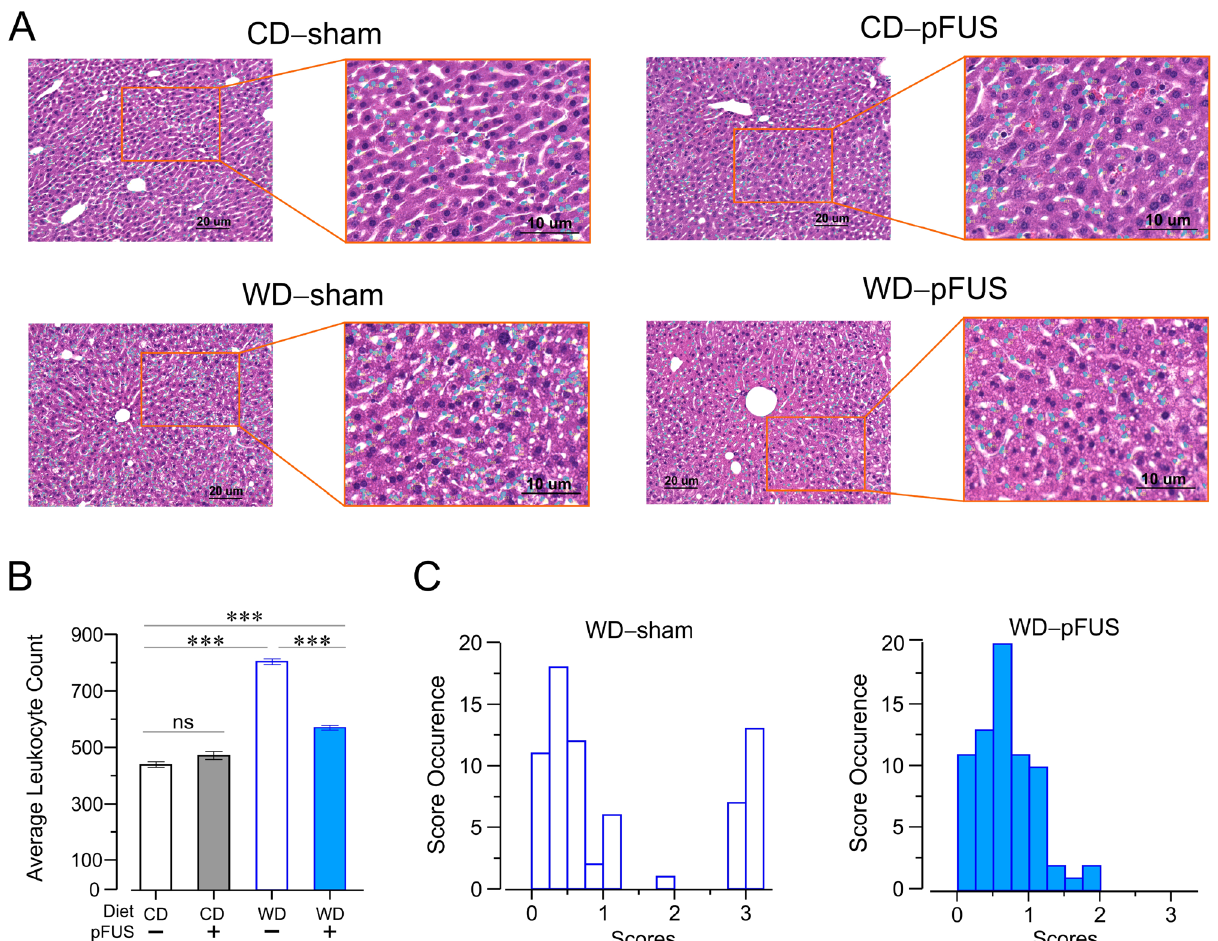
Figure 6. pFUS reduces the volume and severity of leukocyte infiltration in Western diet-fed mice. ( A ) Representative images of H&E stained sections with semi-automated mask for counting immune cells. ( B ) Semi-automatic counting of infiltrating leukocytes. Western diet–pFUS mice had reduced the average number of leukocytes counted per slide compared to Western diet–sham mice (WD–sham, n = 134 sides; WD–pFUS, n = 134 slides; *** P < 0.001, one-way ANOVA). The control diet–sham group had significantly lower counts than the Western diet–pFUS group (CD–sham, n = 64 slides; WD–pFUS, n = 134 slides; *** P < 0.001, one- way ANOVA). ( C ) Severity of immune cell infiltration was quantified and scored in a blinded fashion by a pathologist. The Western diet–sham group had a higher score for inflammation (score 3 is severe), compared